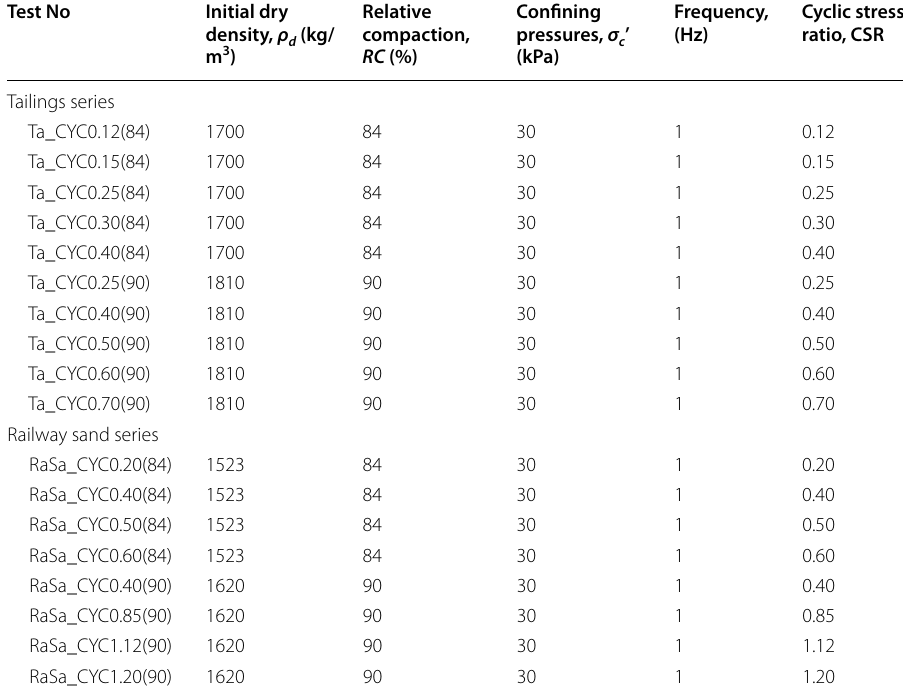
Cyclic stress ratio, CSR